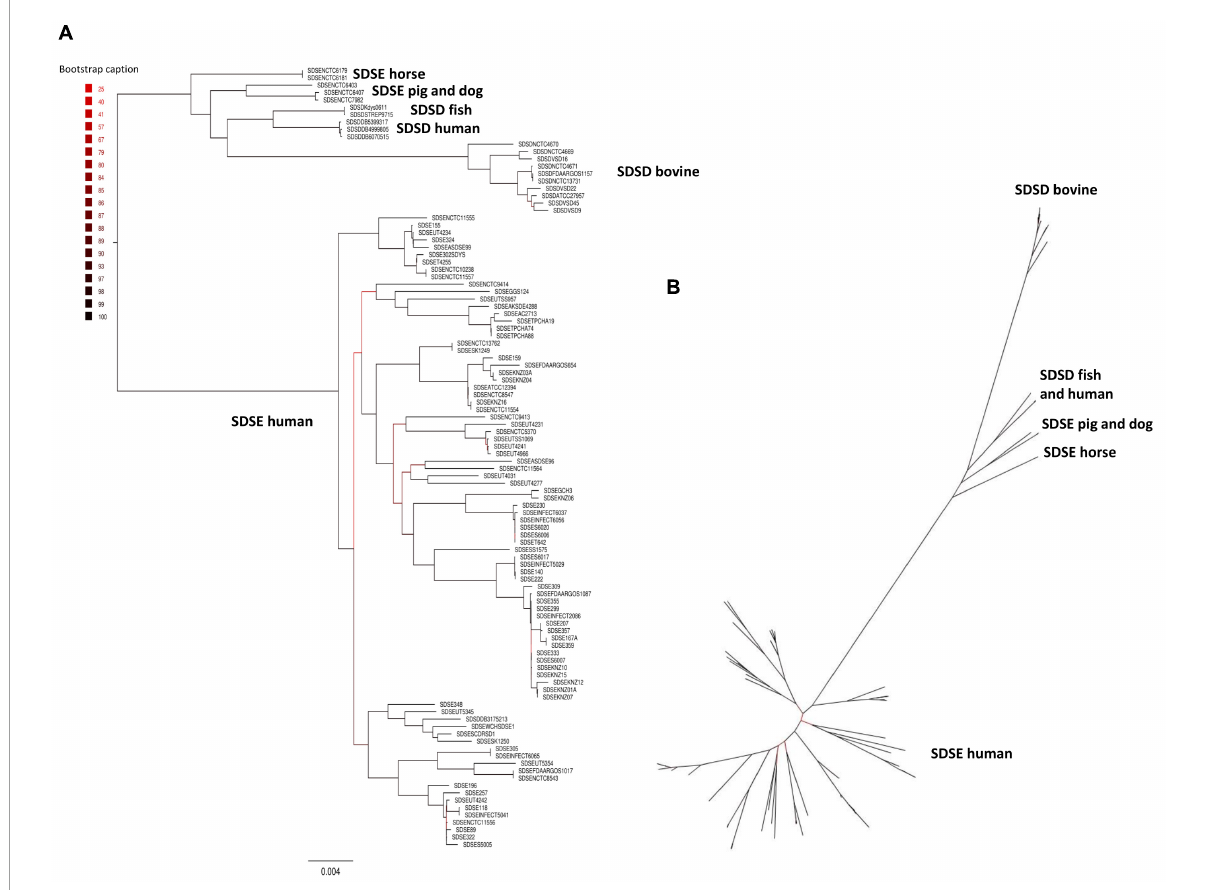
FIGURE2 Phylogenetic analysis of the S. dysgalactiae single-copy core genome. (A) The tree was rooted on the largest branch as the closest outgroup species. (B) Phylogenetic unrooted tree relationships. The evolutionary history was inferred using the maximum likelihood analysis of the alignment of 1,134 single-copy core protein-coding sequences shared by 106 S. dysgalactiae strains. Bootstrap support values were calculated from 1,000 replicates. A phylogenetic tree was generated using IQ-TREE